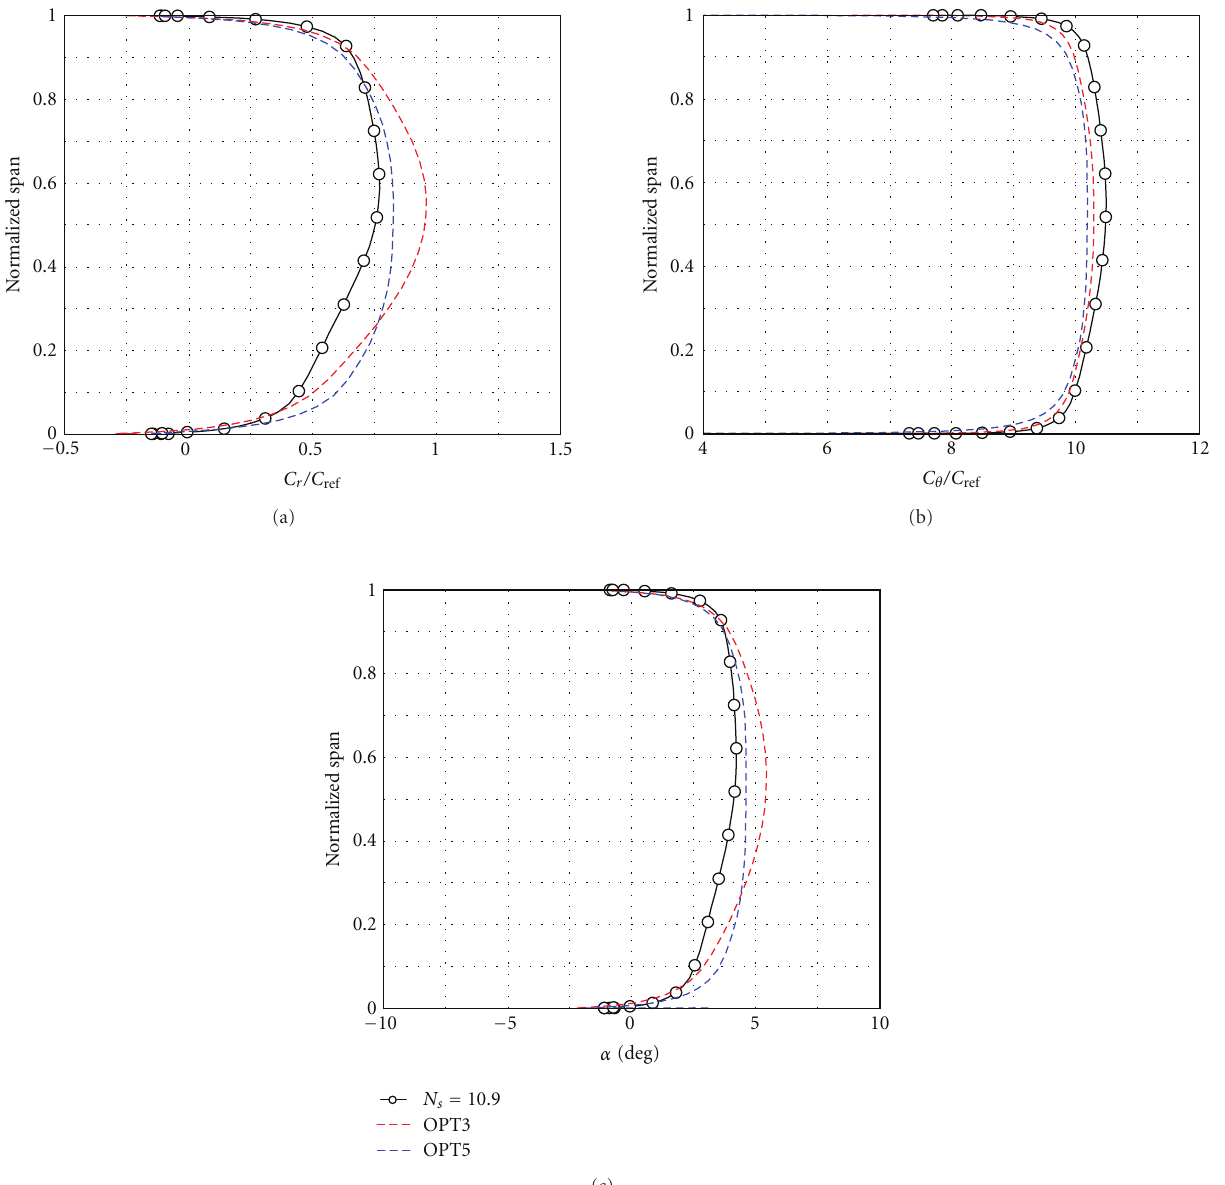
Figure 10: Spanwise distributions at DP in the outlet